Question: Write a single sentence explaining what this figure depicts.
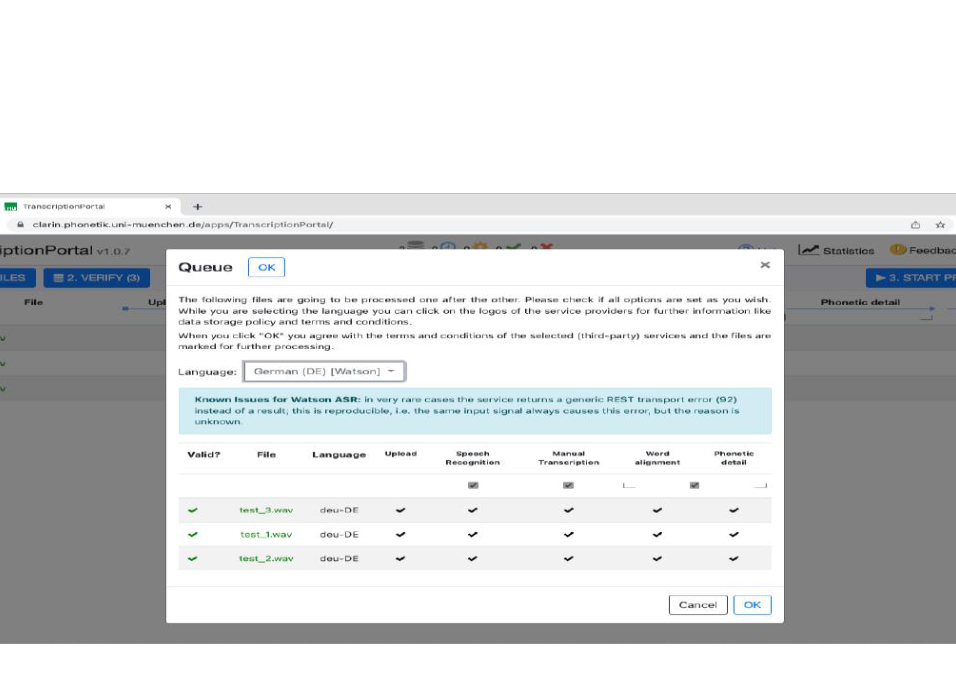
Answer: Selection of ASR language and processing steps in the transcription portal